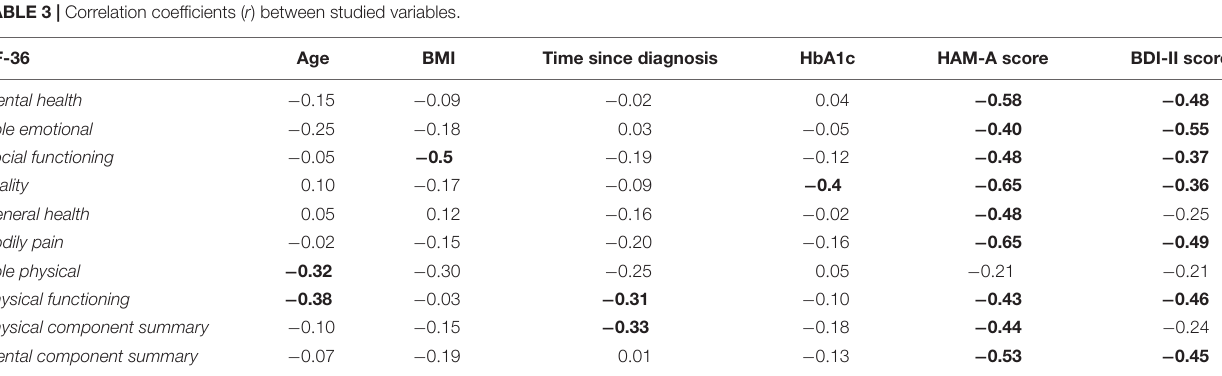
FIGURE 2 | Median Physical Component Summary (PCS) and Mental Component summary (MCS) values according to HAM-A score. TABLE 3 | Correlation coefficients ( r ) between studied variables.